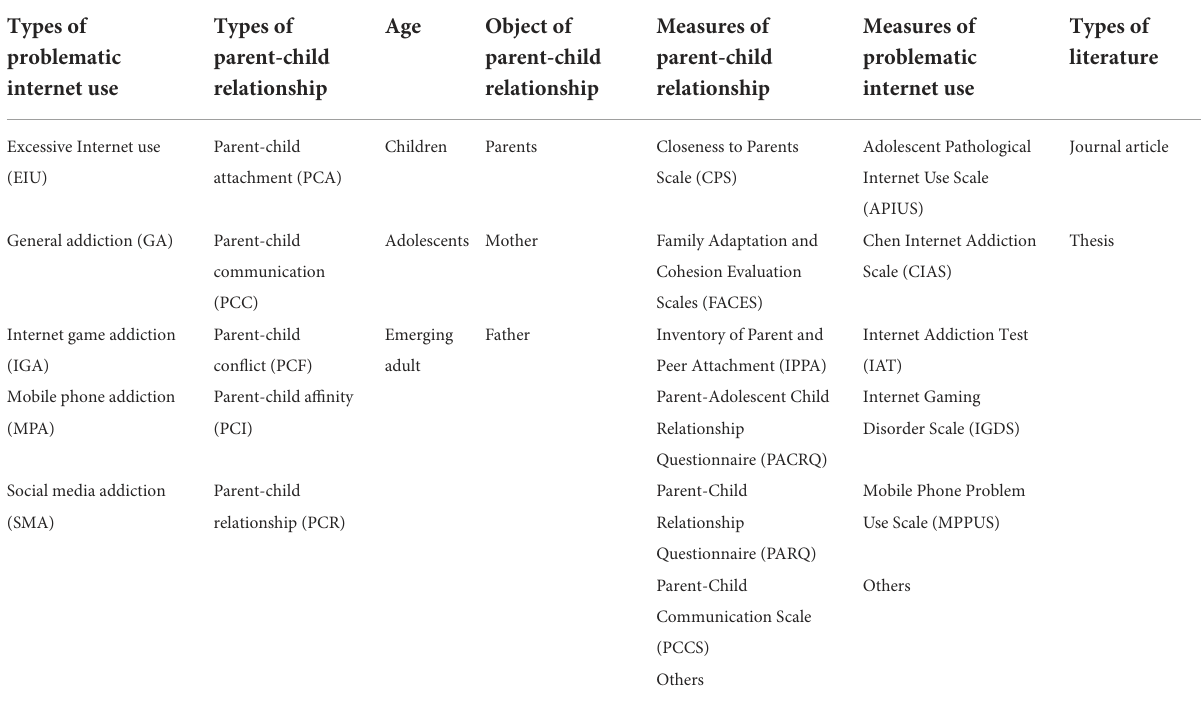
TABLE 1 Types of moderating